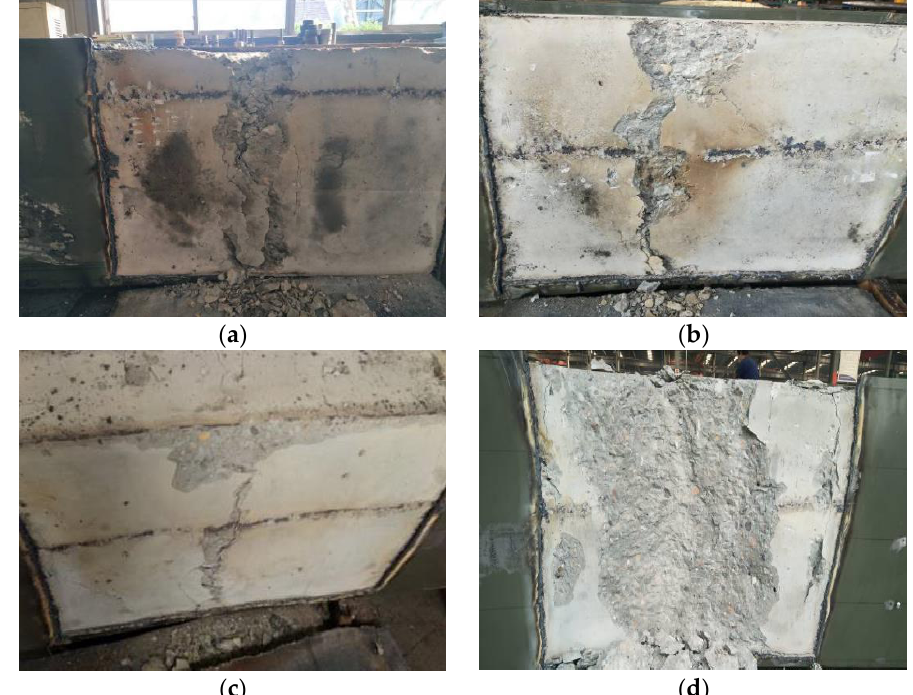
Figure 7. The crushing of concrete in the compression zone on the top of the slabs: ( a ) S-2; ( b ) S-3; ( c ) S-6; ( d ) S-7.